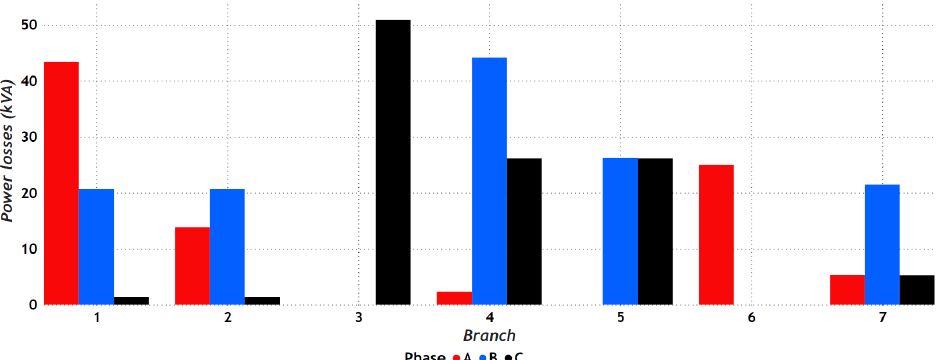
Figure 13. Power losses present in the branches of the three-phase 8-bus distribution system under an unbalanced load